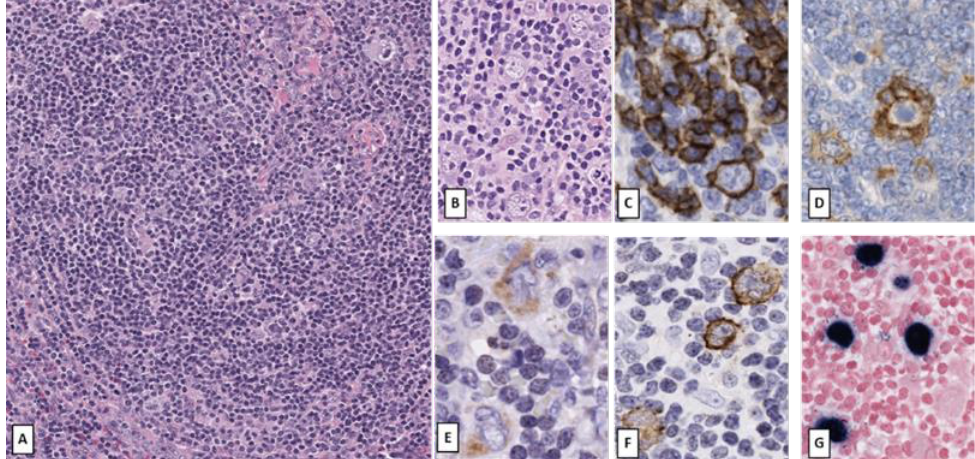
Figure 4. Epstein – Barr virus-positive nodular lymphocyte predominant Hodgkin lymphoma. En- larged cervical lymph node of a 40-year-old female patient. Nodular growth pattern with PTGC- like follicles dominated by small lymphocytes ( A ) with scattered LP cells ( B ) which show a strong positivity for CD20 ( C ). PD1 positive follicular T helper lymphocytes ( D ) rosetting around LP cells, which variably express CD30 ( E ). LMP1 ( F ) and EBERs ( G ) positivity confirms association with EBV. (Original magnification: A: ×200; B: ×400; C – G: ×600)]. Differential Diagnosis with CHL Morphologically, NLPHL shows similarities to lymphocyte rich CHL, which was separated from NLPHL mainly by the work of the German Hodgkin lymphoma study